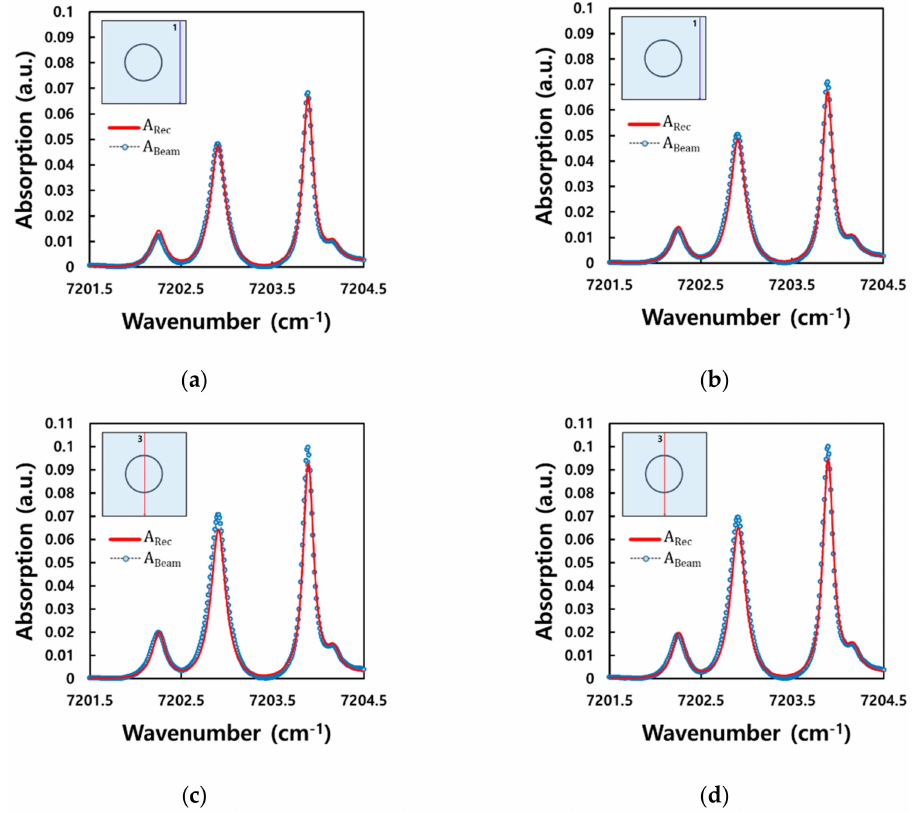
Figure 6. The spectra of reconstructed and measured absorption data at the engine running time 5.0 s: